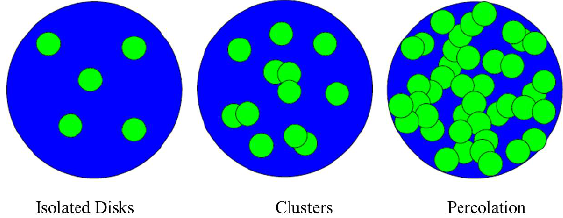
Figure 3. ( Left ) Isolated disks; ( Middle ) Cluster formation; ( Right ) Overlapping discs forming a cluster of communication